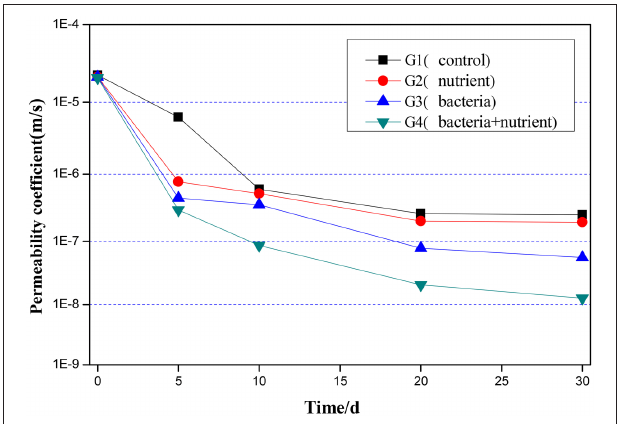
FIGURE 7 | Water permeability of specimens with different treatment after different healing time.